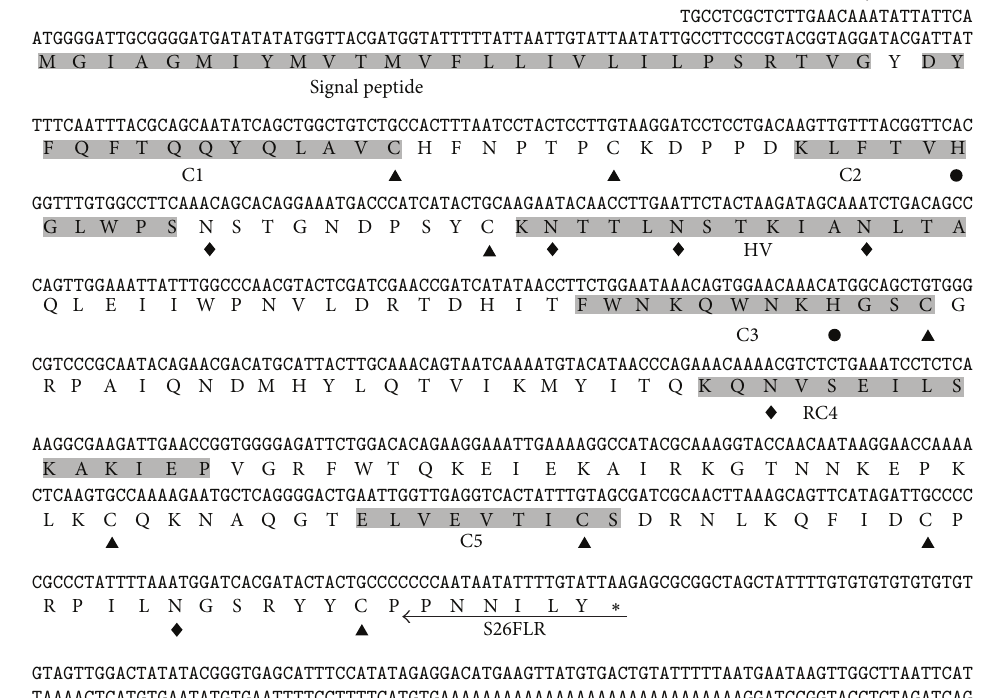
Figure 1: Nucleotide and deduced amino acid sequences of the full length PbS -RNase cDNA. The signal peptide, C1 to C5 domains, and 26 HV region are shaded. Conserved cysteine residues, histidine residues essential for the RNase activity, and potential N-glycosylation sites are marked with symbols 󳵳 , e , and X , respectively, under the amino acid sequence. Asterisk indicates termination codon. MGIAGMIYMVTMVFLLIVLILPSRTVGYDYFQFTQQYQLAVCHFNPTPCKDPPDKLFTVHGLWPSNSTGNDPSYCK